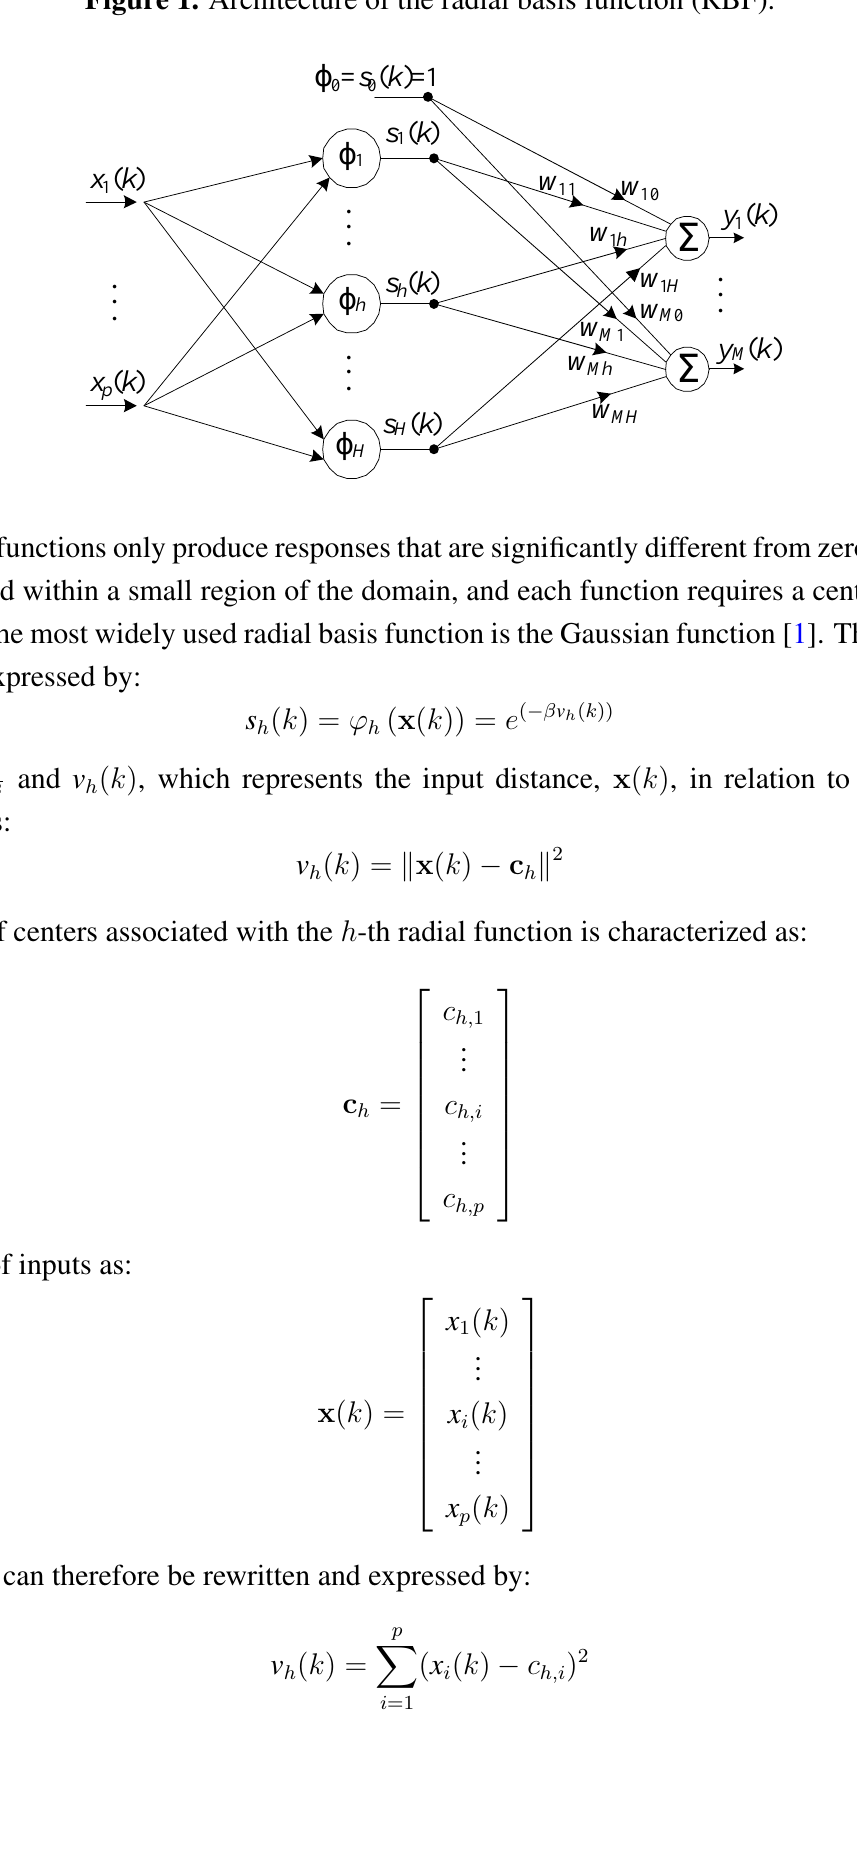
Figure 1. Architecture of the radial basis function